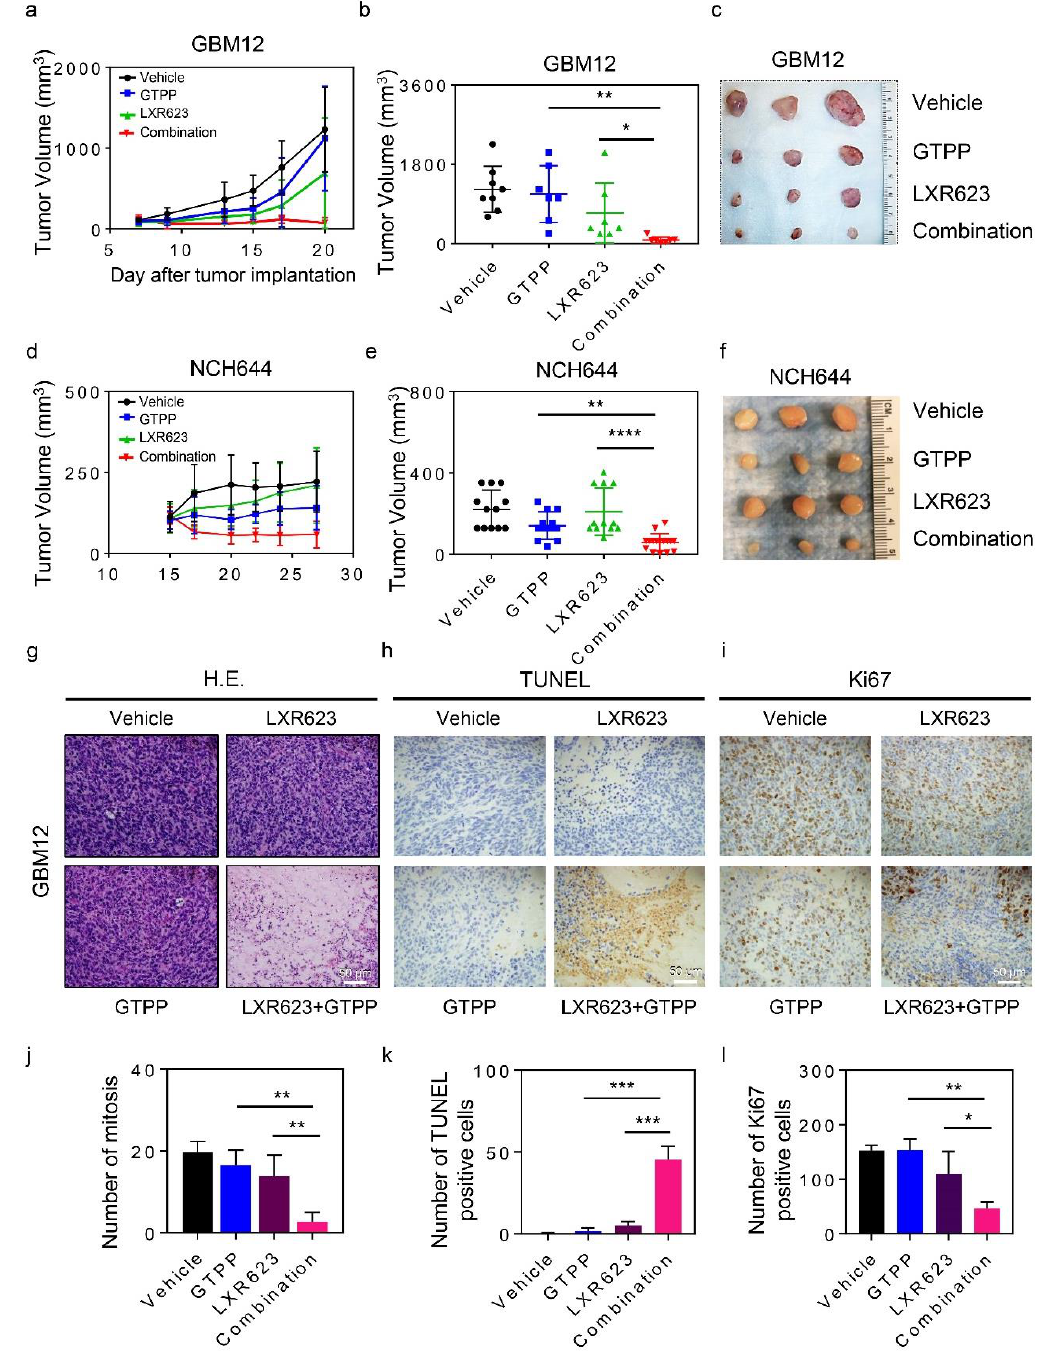
Figure 6. The combination treatment of gamitrinib and LXR623 elicits synergistic tumor growth in vivo. ( a ) GBM12 Patient-Derived Xenograft (PDX) tissue was implanted subcutaneously. After tumor formation, groups were formed. Animals were treated intraperitoneally with vehicle, LXR623 (200 mg/kg), GTPP (5 mg/kg), or both agents (six treatments provided during each size measurement). Tumor growth curves show the development of tumor size for each treatment group. Shown are means and SD ( n ≥ 8). ( b ) Scatter plots display the quantitative representation of the tumor size among the different treatments toward the end of the experiment. Shown are means and SD ( n ≥ 8). ( c ) Gross images of the in vivo xenograft experiments described in ( a ). ( d ) 1 × 10 6 NCH644 cells were implanted subcutaneously. After tumor formation, groups were formed. Animals were treated intraperitoneally with vehicle, LXR623 (200 mg/kg), GTPP (5 mg/kg), or both agents (six treatments provided during